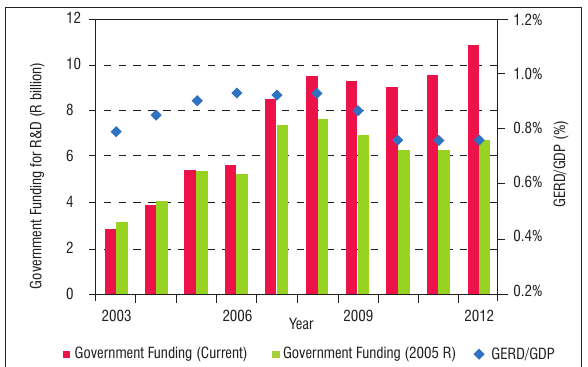
Figure 1: Government funding of R&D (2003 to 2012).